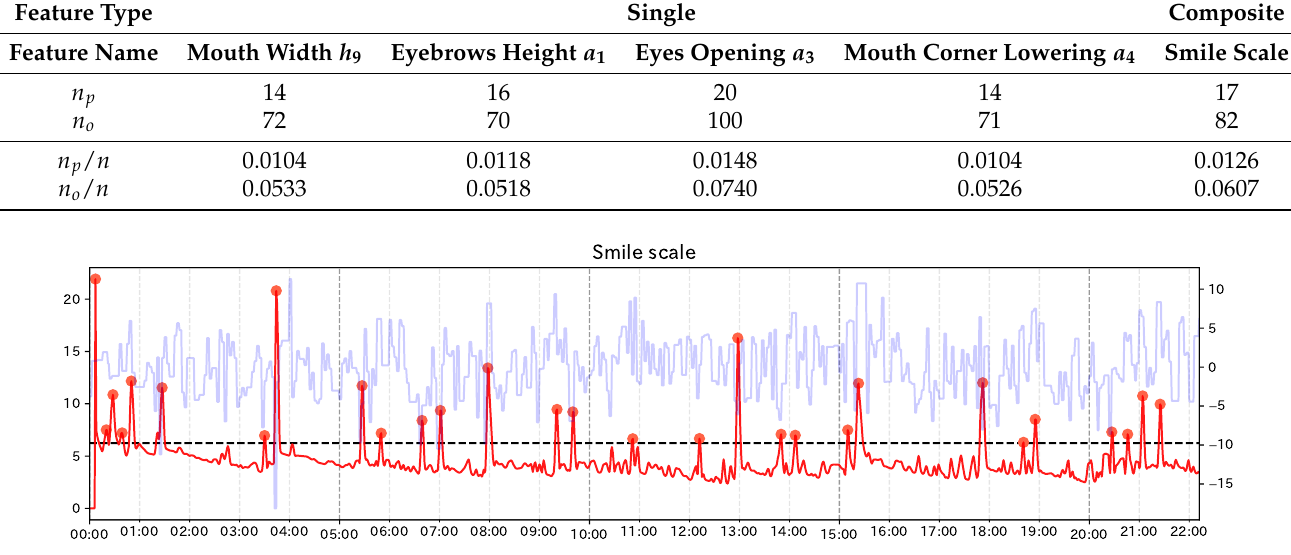
Figure 11. Graph of the change score for the Smile scale (Subject B).